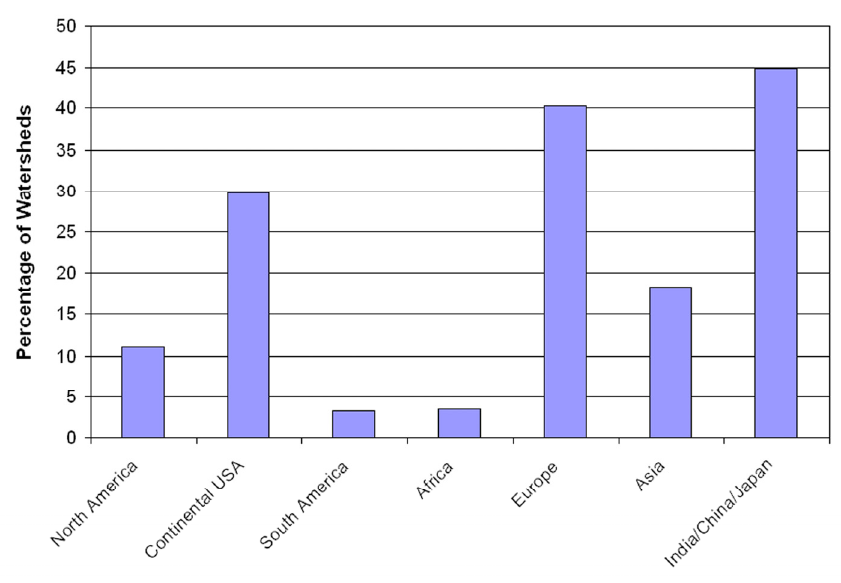
Figure 13. Percentage of watersheds having 50% or more of their surface in the stressed category (1-10% constructed impervious surface